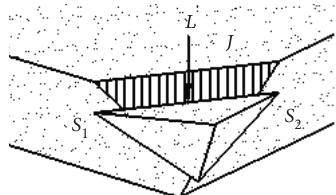
Figure 8: Model of single sliding surface.